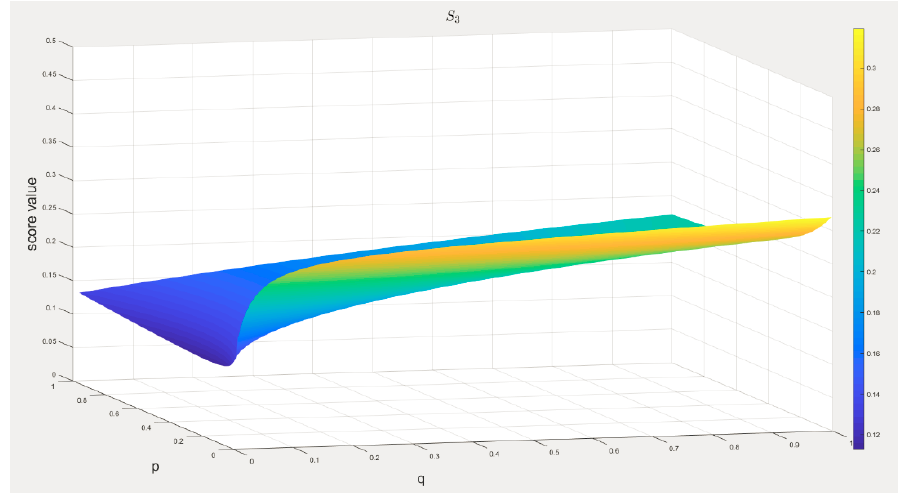
S with , [0,1] p q . 3